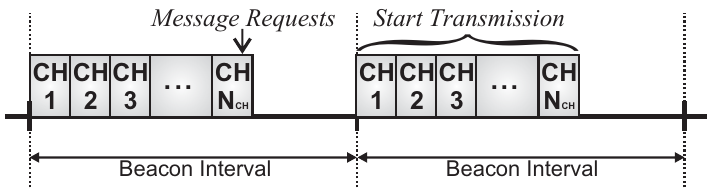
Figure 9. Worst-case scenario for cluster-tree networks.